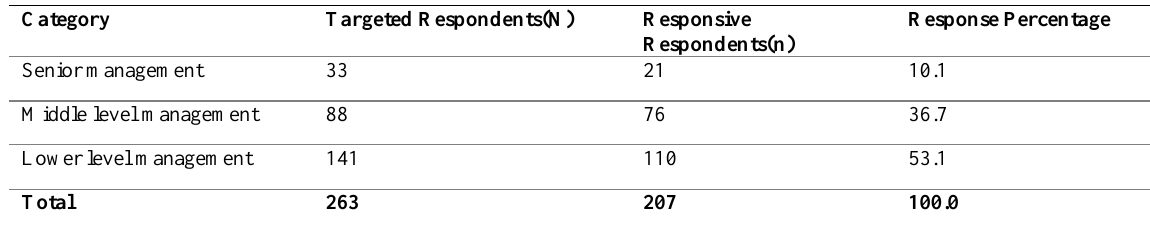
Table 2 : Questionnaires Return